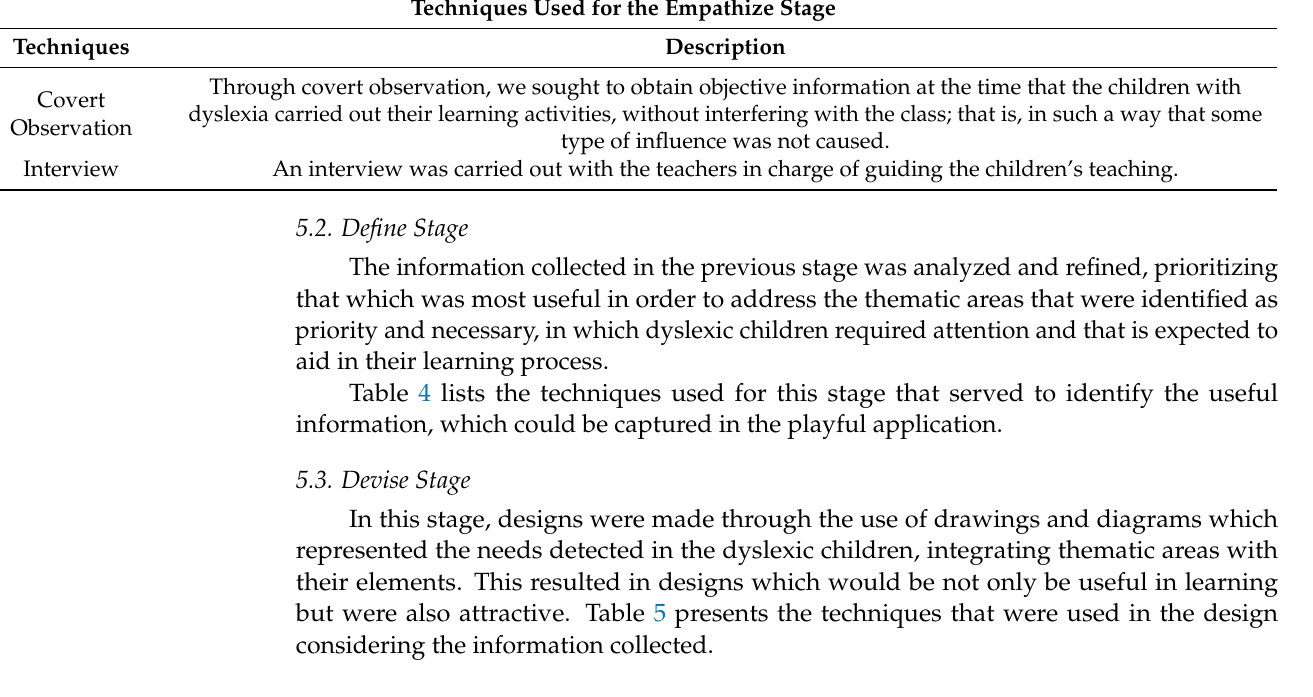
Table 3. Description of techniques used in the Empathize stage. Techniques Used for the Empathize